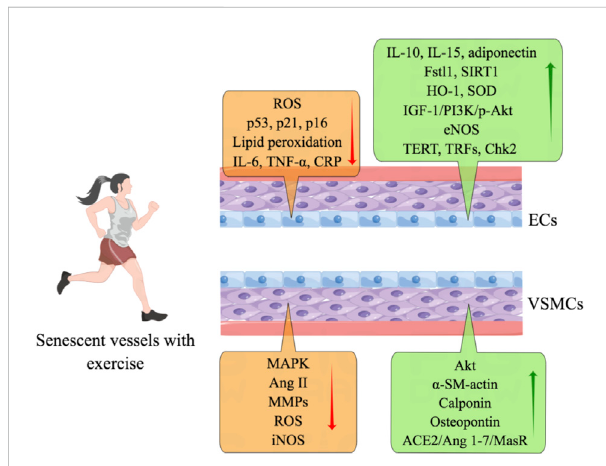
FIGURE 5 Exercise preserves senescent vascular function. Exercise counteracts endothelial senescence through anti-oxidative and anti- in fl ammatory mechanisms and by reducing lipid peroxidation. Physical activity also increases the expression of IL-10, IL-15, adiponectin, Fstl1, SIRT1, HO-1, SOD, IGF-1/PI3K/p-Akt, eNOS, TERT, TRFs, and Chk2. Physical exercise improves the function of senescent VSMCs by inhibiting the expression of MAPK, Ang II, MMPs, ROS, and iNOS. And exercise facilitates the productions of Akt, α -SM-actin, calponin, osteopontin, and ACE2/Ang